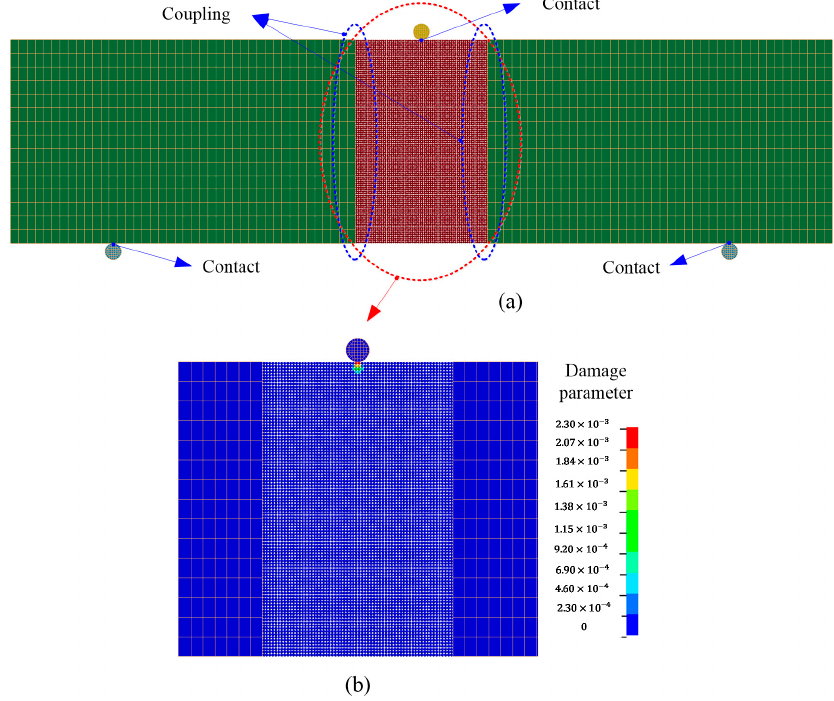
Fig. 28 Figure 28. ( a ) Coupled model; ( b ) initial damage upon impact at t = 0.04